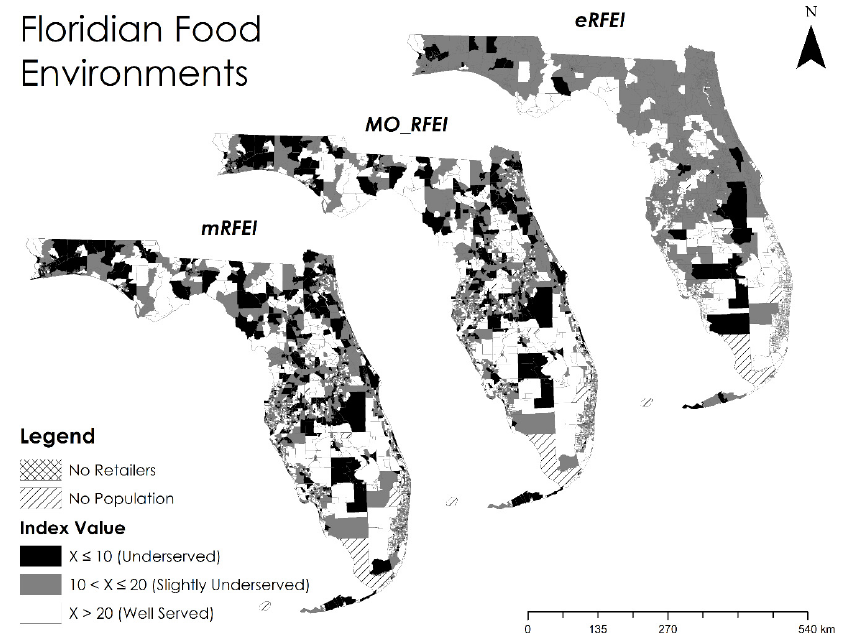
Figure 3. The mRFEI, MO_RFEI, and eRFEI by census tract in